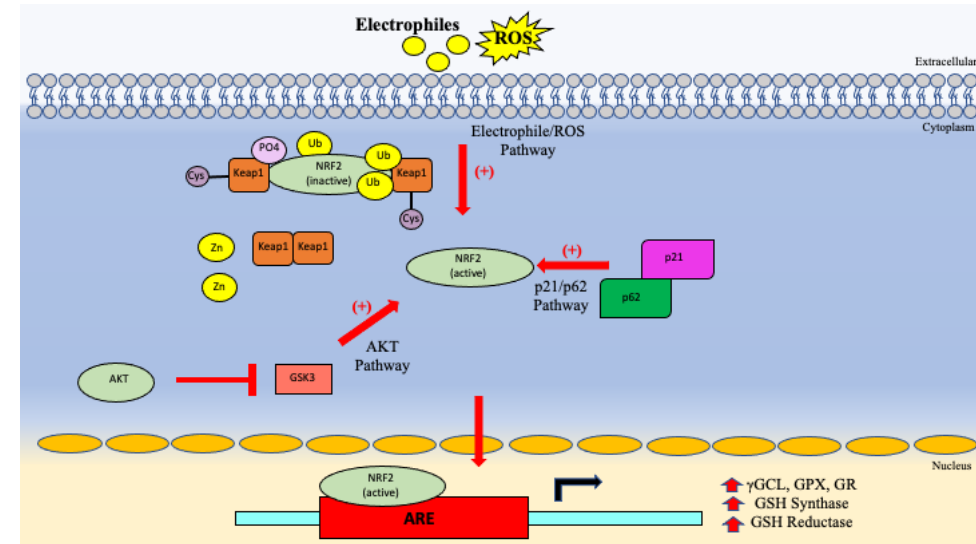
Figure 6. Pathways that affect the major genes which promote or affected in